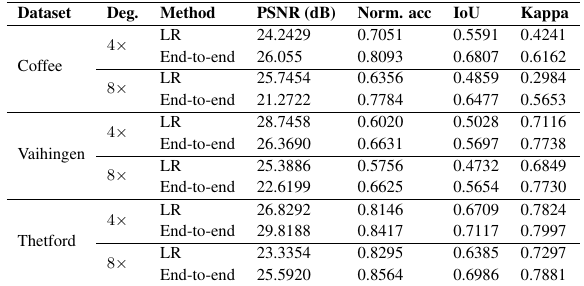
Table 2. Comparison between the performance of a Segnet trained only with LR data and the end-to-end